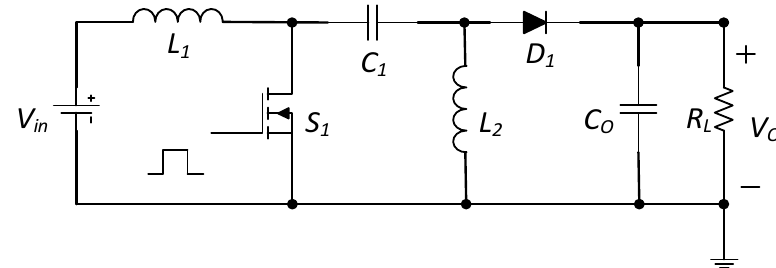
Figure 4. Original single-ended primary inductor converter (SEPIC) converter circuit.